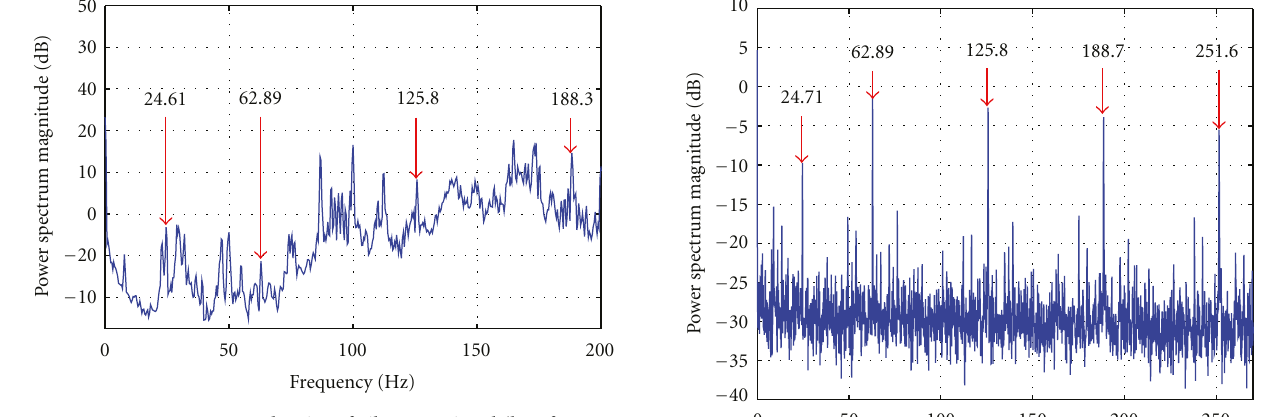
Figure 7: Power spectrum density of vibratory signal (low frequen- cies).